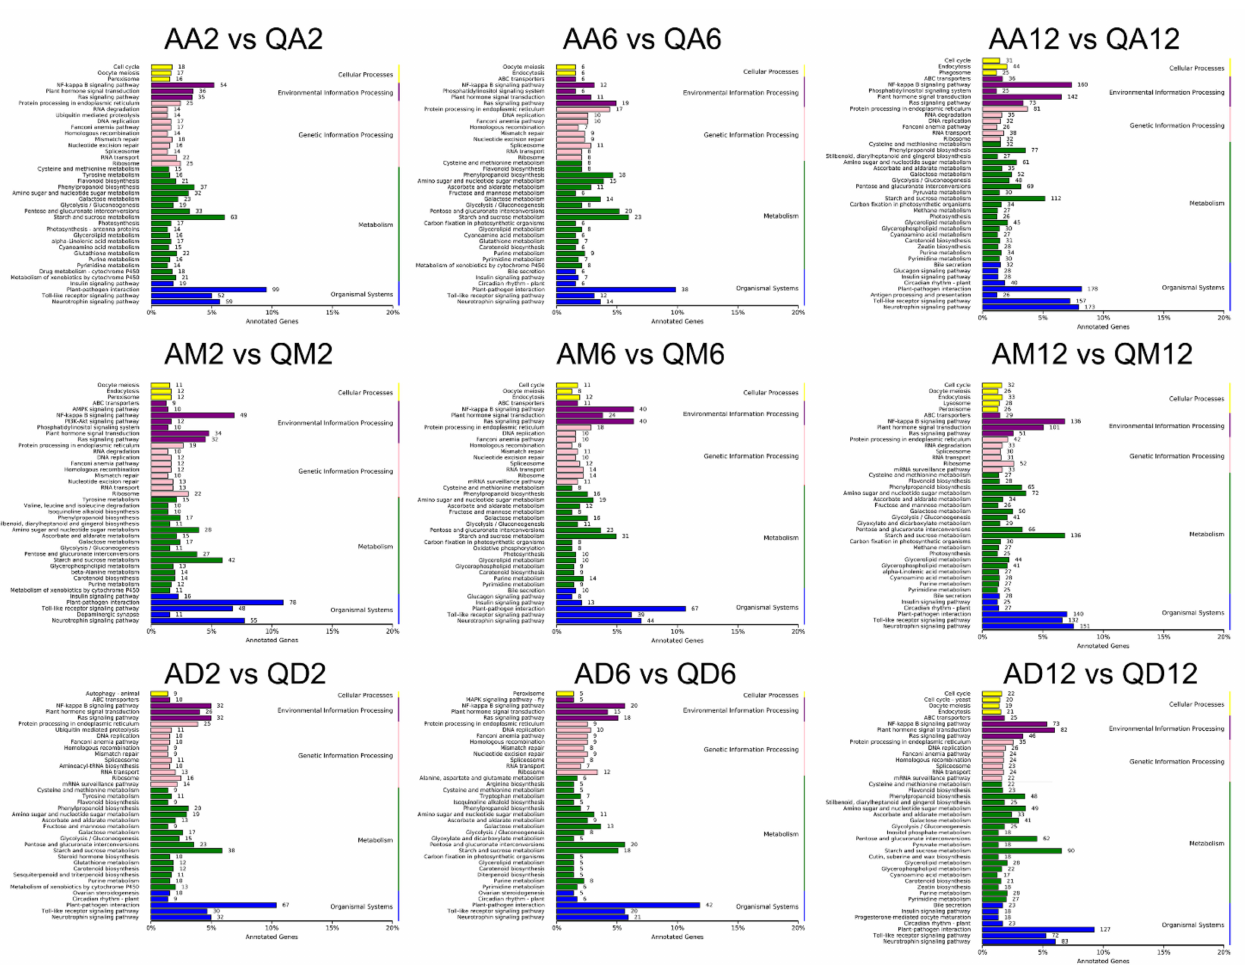
Figure 5. Annotation and functional enrichment of DEGs in KEGG database. Histogram of the most enriched KEGG pathway of potato DEGs under treatment. The ordinate is the enriched KEGG pathway; the abscissa is the number of DEGs on the column. Different colors distinguish cellular pro- cesses, environmental information processing, genetic information processing, metabolism, cellular components, and organismal